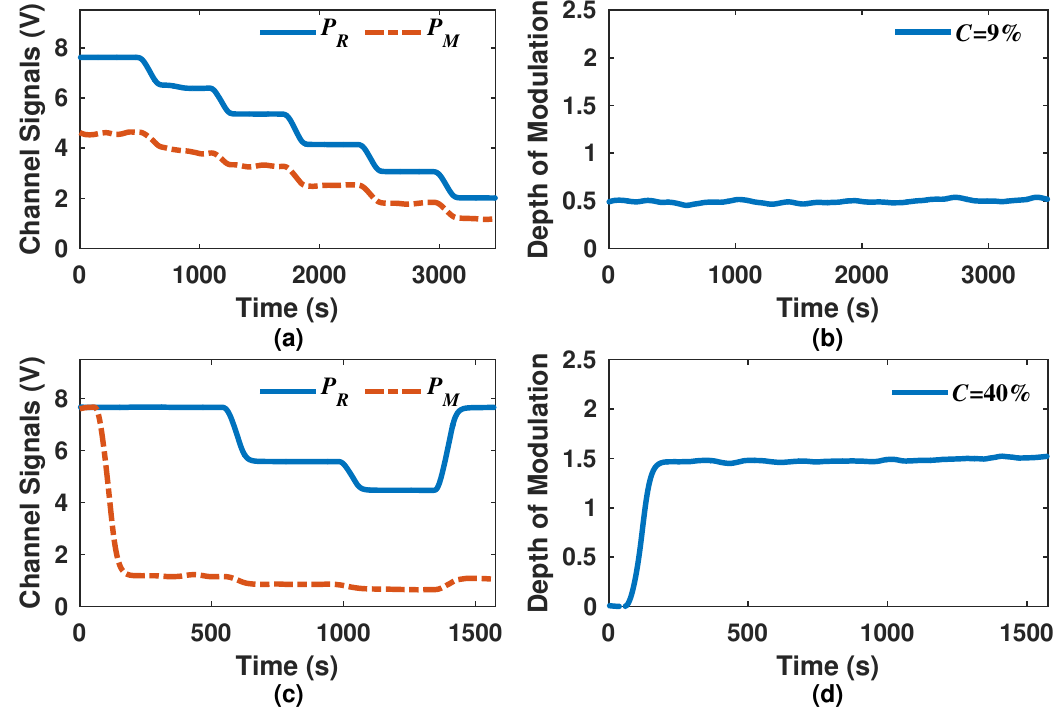
Figure 7. ( a , c ) Measured channel signals showing the effect of varying the light intensity. ( b , d ) calculated depth of modulation showing that it is unaffected by light intensity variations. For ( a , b ) the C 2 H 2 concentration was 9% and for ( c , d ) it was